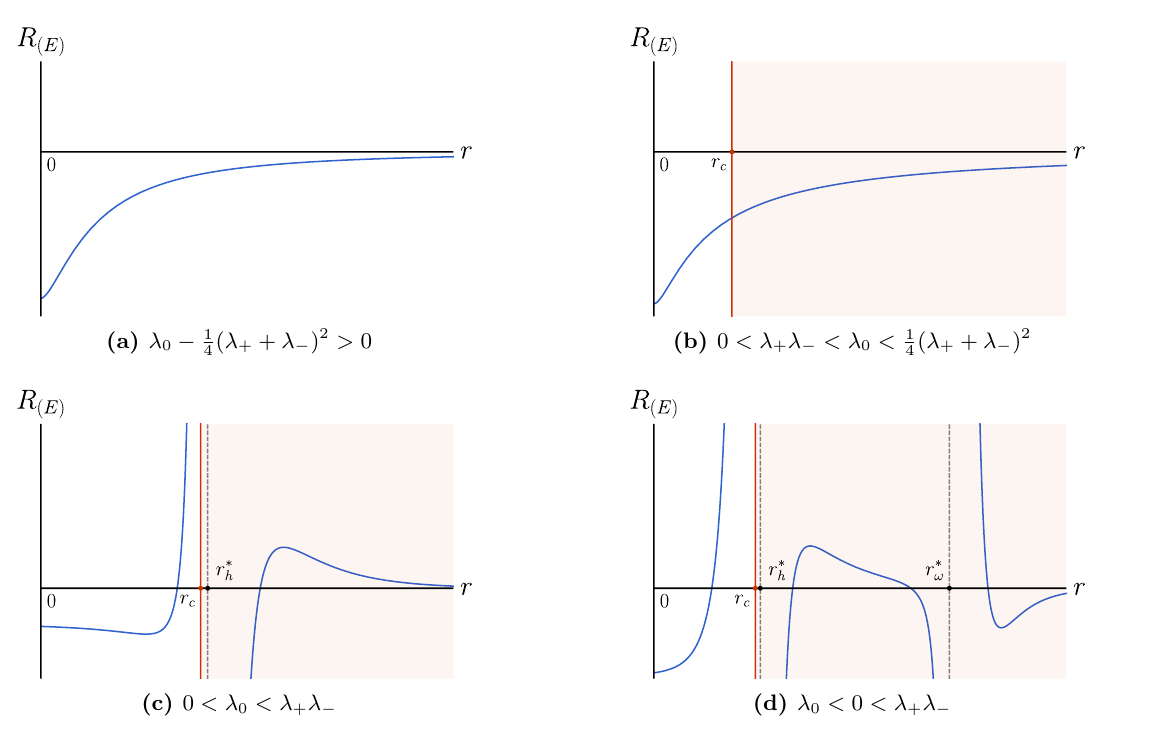
Figure 3. The Ricci scalar for generic values of the phase space variables and different choices of the deformation parameters of the charged tri-TsT black hole (not drawn to scale). In these plots we have assumed that λ 0 but a similar behavior is found when λ 0 provided that the + λ − > + λ − < inequalities in (4.4) are handled